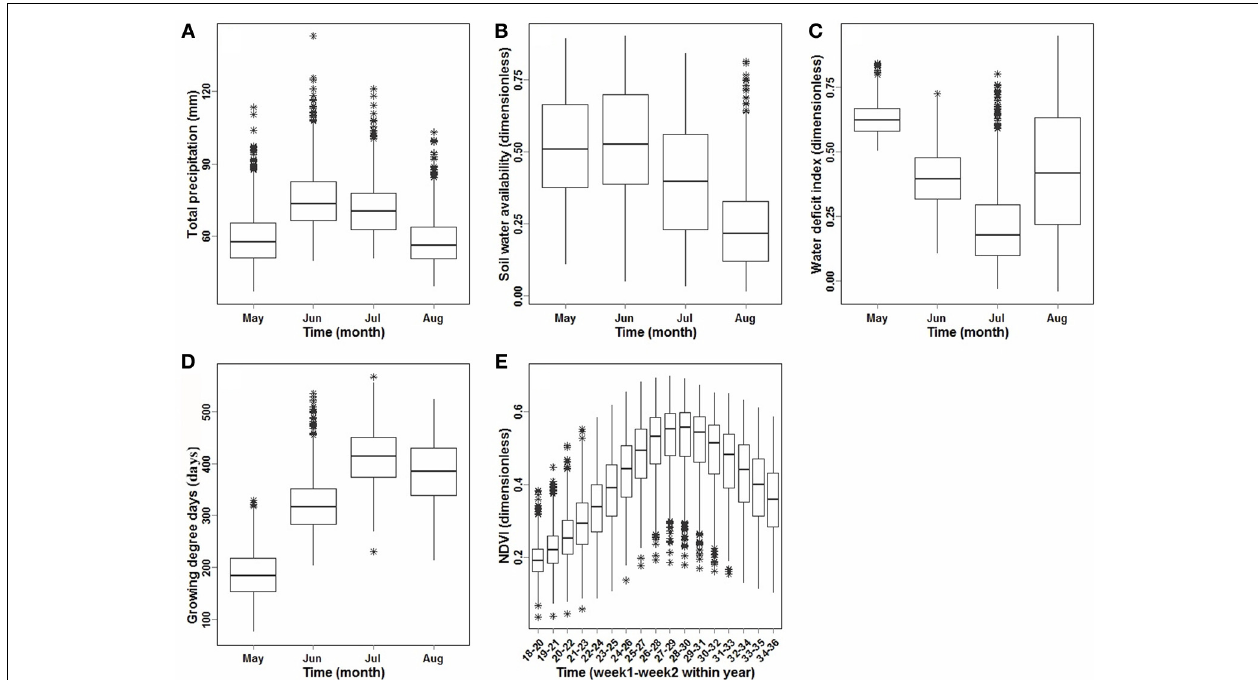
FIGURE 3 | Observed distribution and variability of agro-climate and NDVI variables, through the growing season (May–September) based on historical data, 1987–2011. (A) Average total monthly precipitation